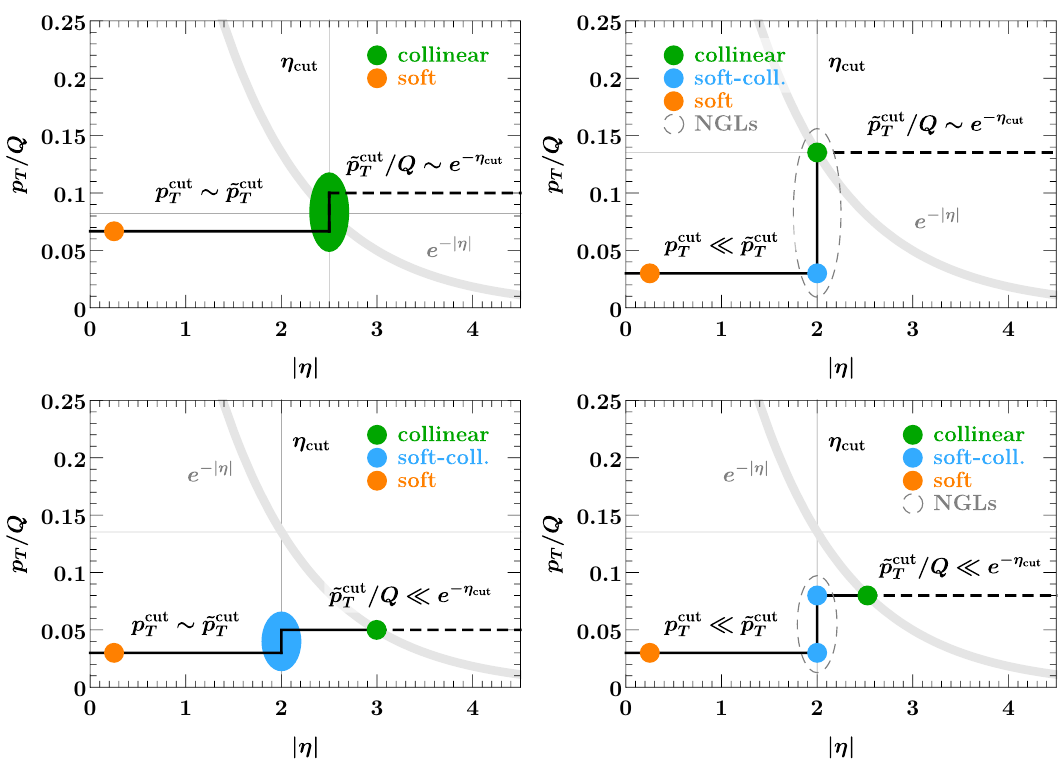
Figure 7 . Illustration of the parametric regimes for a jet veto with a step. Emissions above the black lines are vetoed, and the thick gray line corresponds to p T =Q = e (cid:0)j (cid:17) j . The colored circles indicate the relevant modes in the e(cid:11)ective theory. The regimes in the top row are characterized by ~ p cut